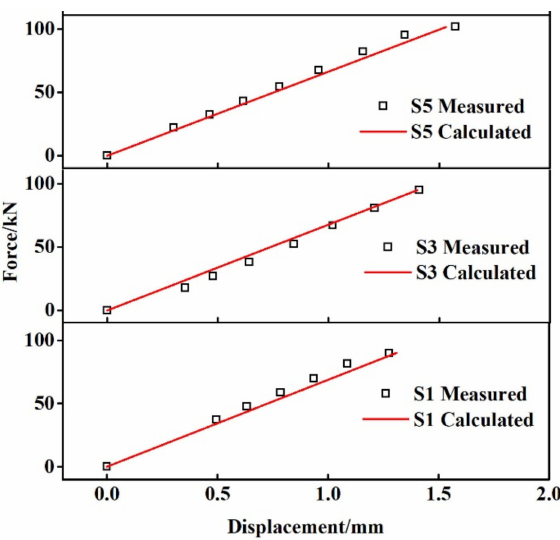
Figure 8. Comparison of calculated and measured results of elastic